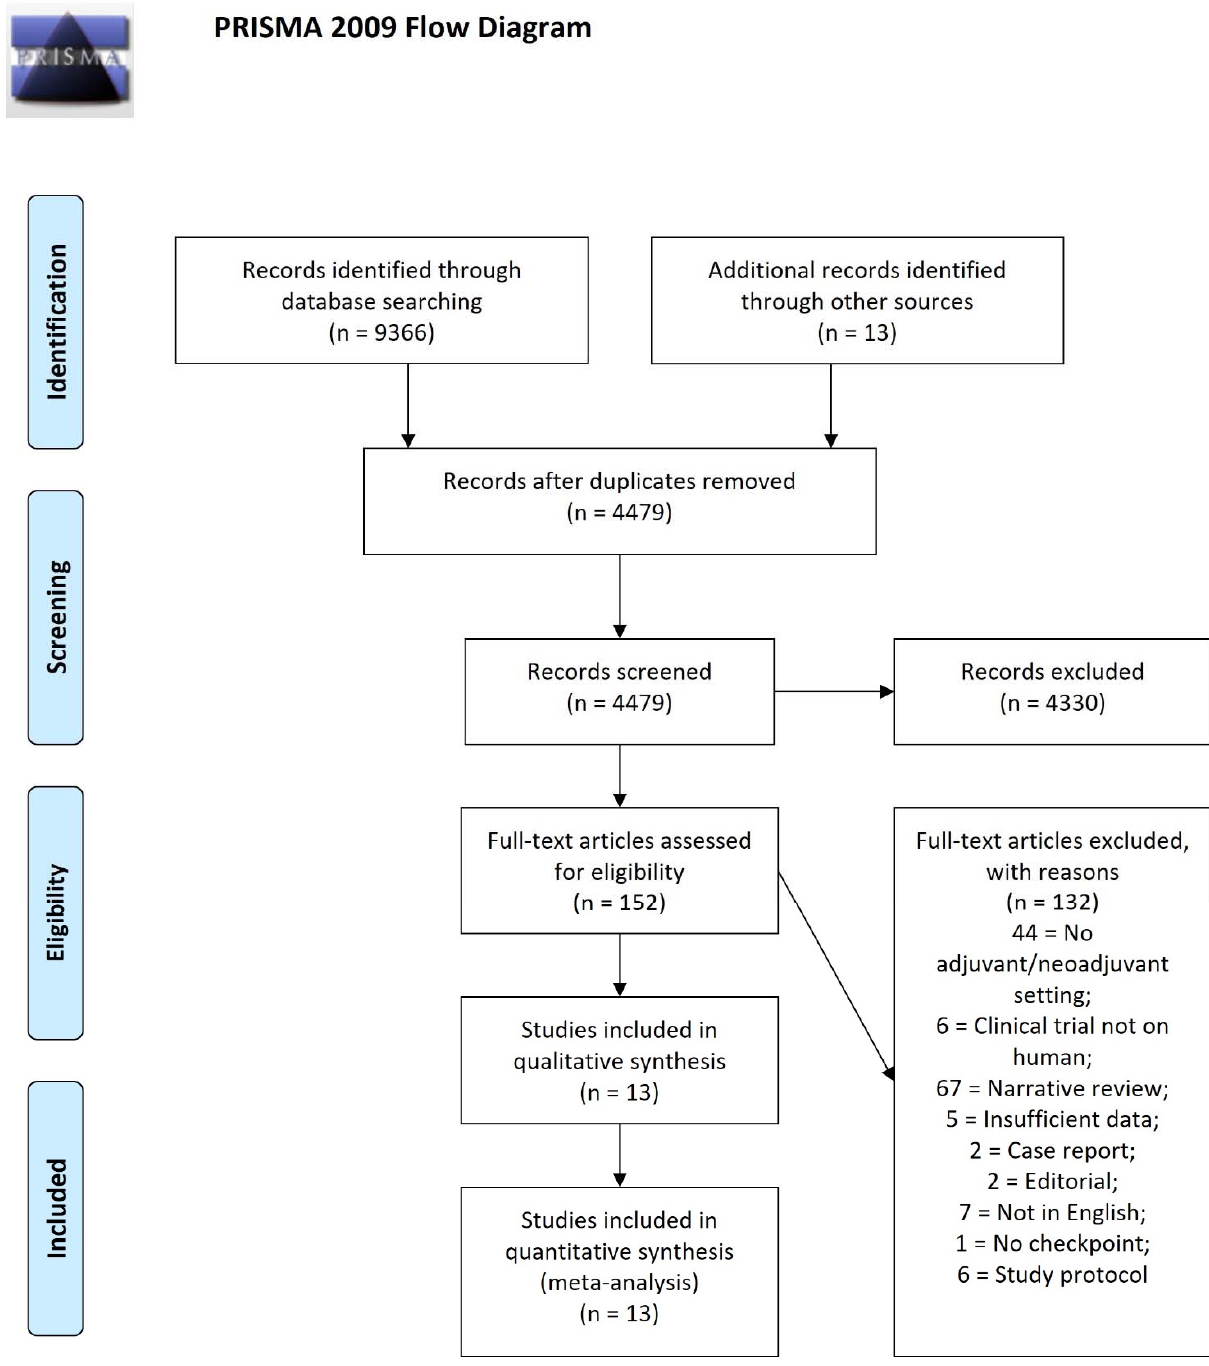
Figure 1. PRISMA flowchart of the reviewed manuscripts. From: Moher D, Liberati A, Tetzlaff J, Altman DG, The PRISMA Group (2009). Preferred Reporting Items for Systematic Reviews and Meta ‐ Analyses: The PRISMA Statement. PLoS Med 6(7): e1000097. doi:10.1371/journal.pmed1000097